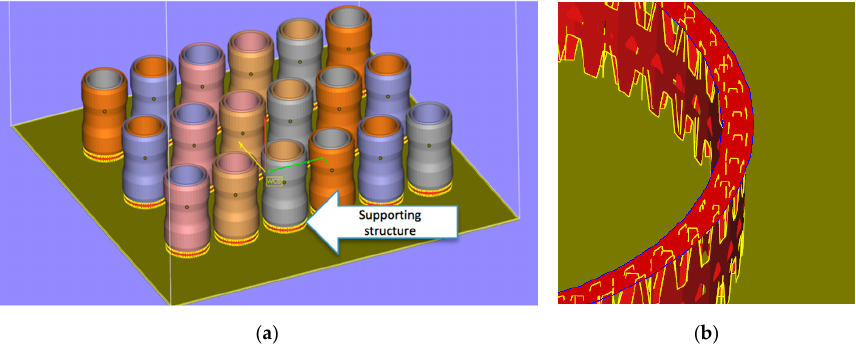
Figure 4. Arrangement of the samples in the 3D printer space: ( a ) overview; ( b ) example of supportive structure.